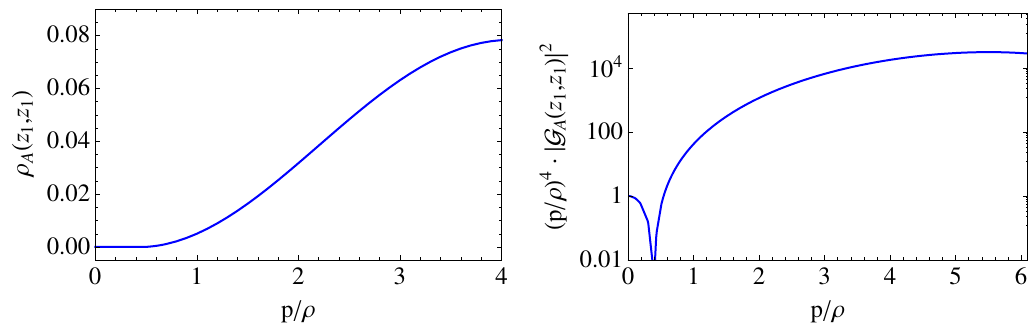
Figure 12 . Scale invariant spectral density (left panel) and squared absolute value of the Green’s function (center panel) for gauge bosons, for the case z = z 1 and z 0 = z 1 . We have used A 1 = 35 and c =